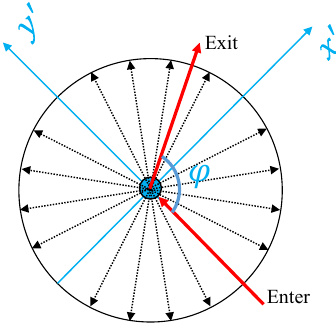
Figure 4. Local coordinate system for angle computation and quantization into discrete angle representation. The illustrated figure uses 20 bins.